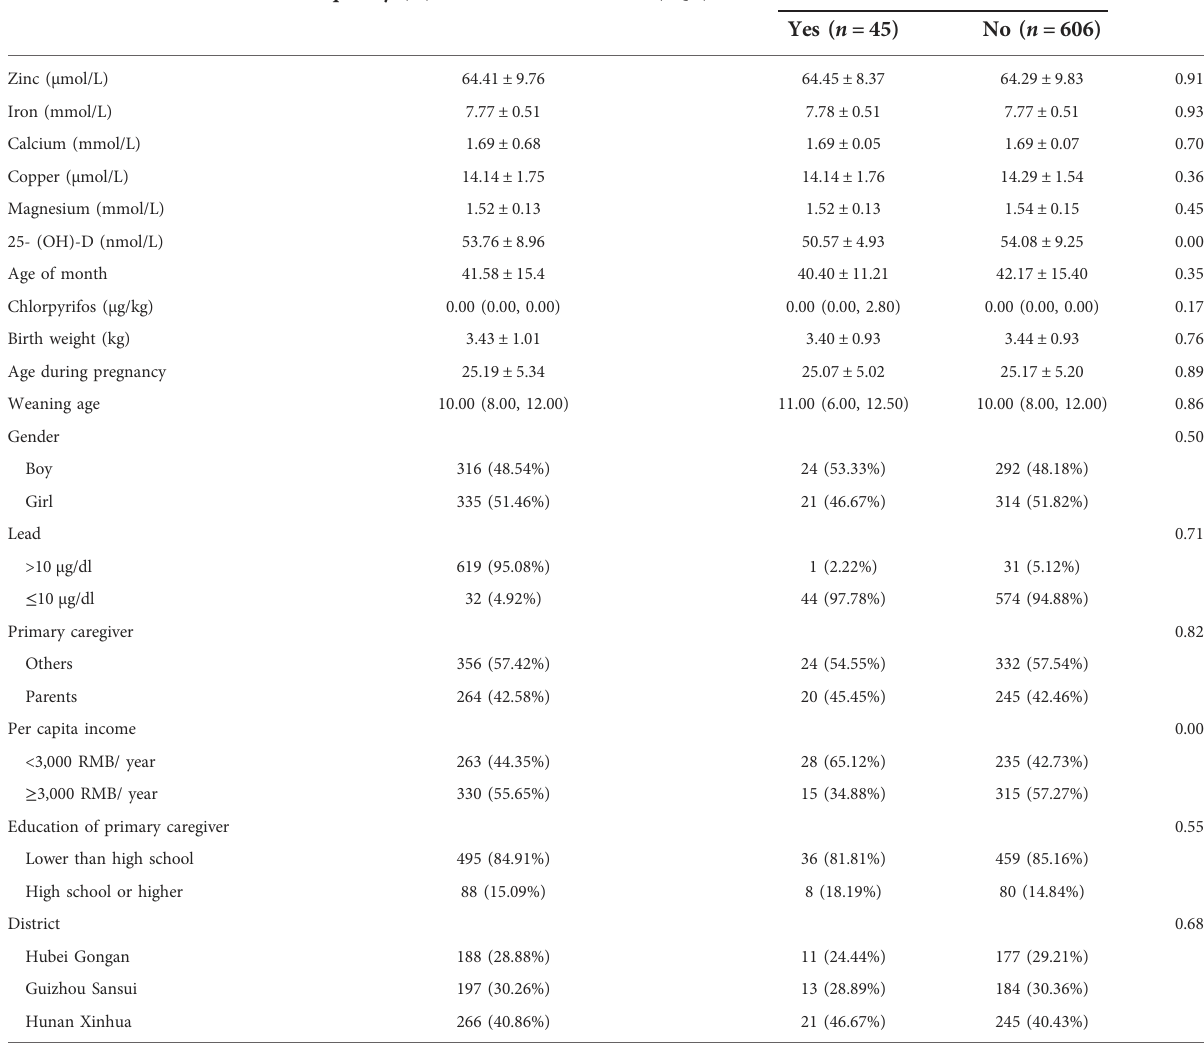
TABLE 1 Cross-sectional survey results and ADHD univariate analysis results.